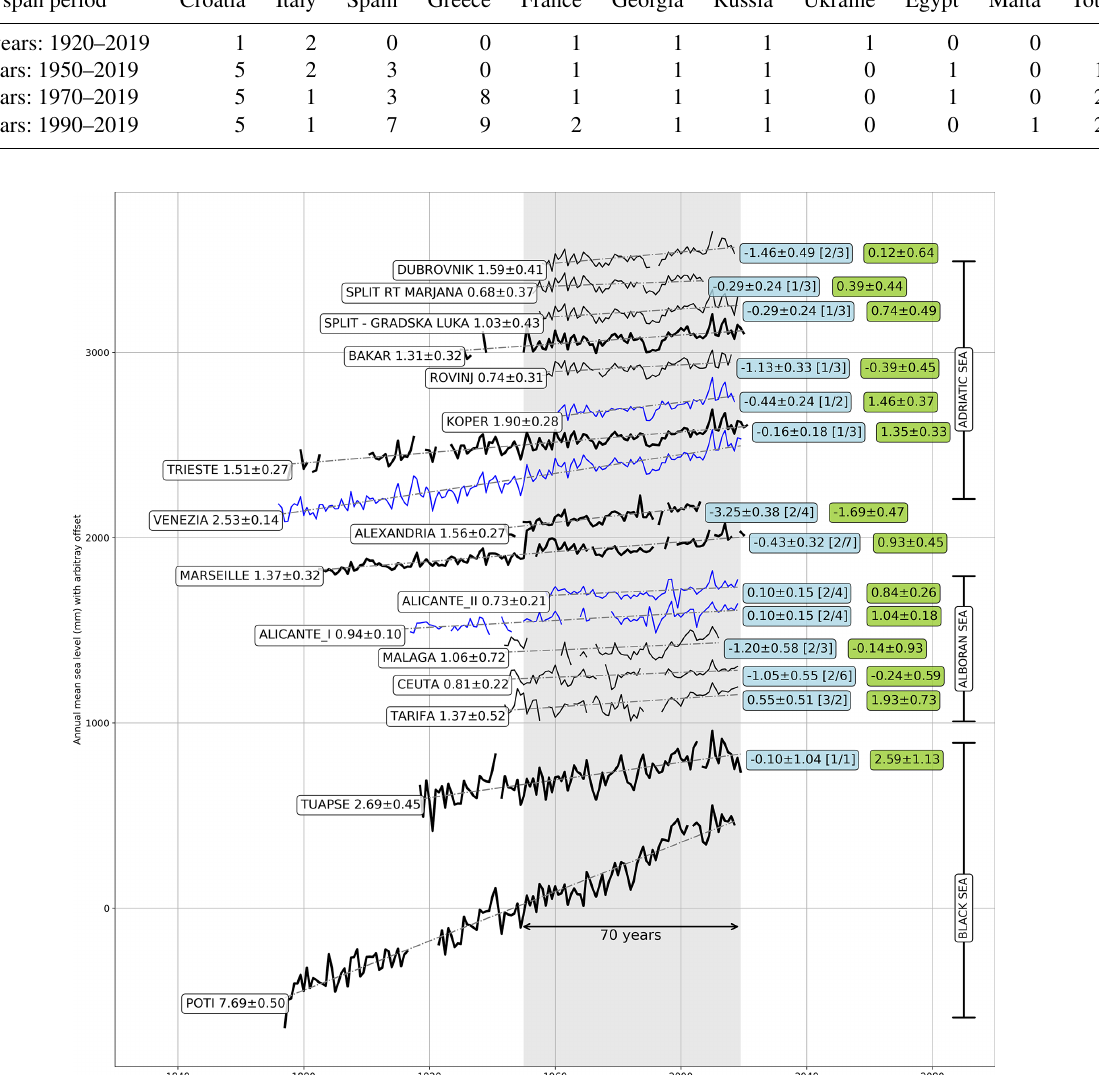
Figure 9. Mean sea level evolution of the 70-year-long sea level records. The curves in black are for data from the PSMSL, those bold are the 100-year-long records, and those in blue the updated or new records, not available in the PSMSL. The name of the station is followed by the relative sea level trend; in the light blue boxes on the right of the curve is indicated the rate of VLM computed from different collocated GNSS stations and different solutions. The number in brackets indicates the number of GNSS stations/the number of solutions (i.e. [2 / 7] means two collocated GNSS and seven different solutions) considered in the computation of the VLM estimates. The green boxes indicate the rate of absolute sea level change computed from the addition of relative sea level trend and vertical land motion. All estimates are in millimetres per